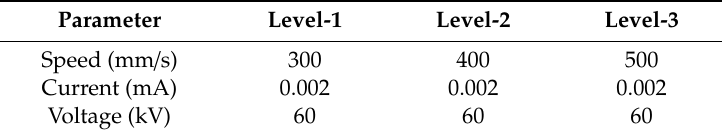
Table 5. The levels of scan speed changes.